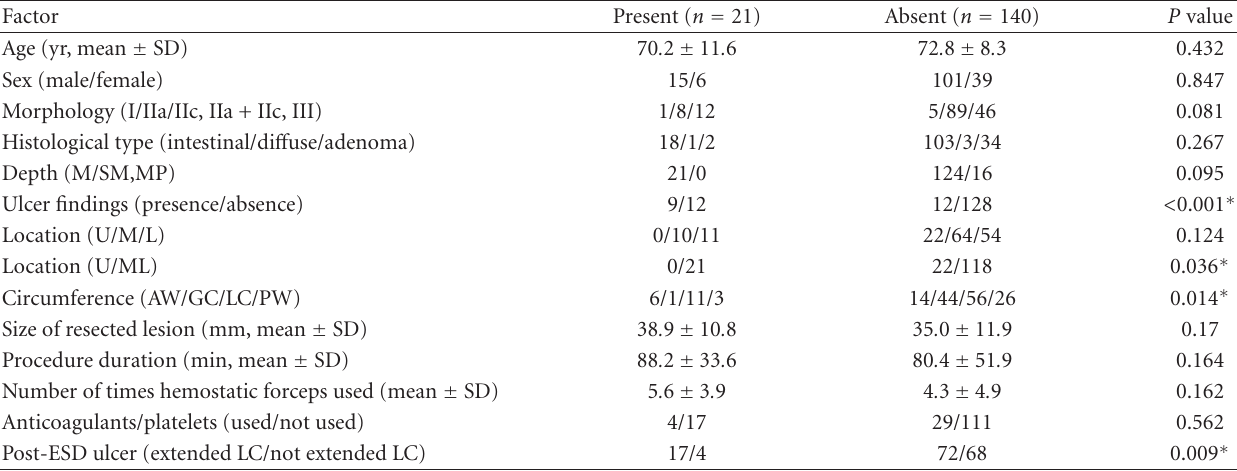
Table 2: Univariate analysis of delayed bleeding.